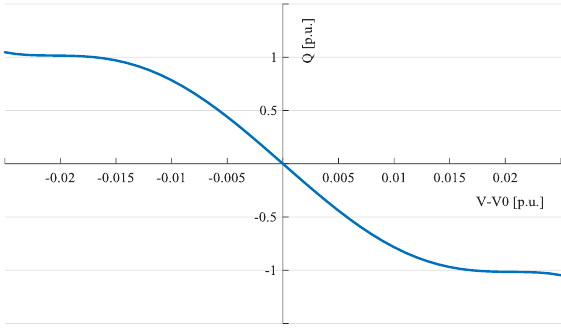
Figure 4. Polynomial Q(U) characteristic of wind farms.